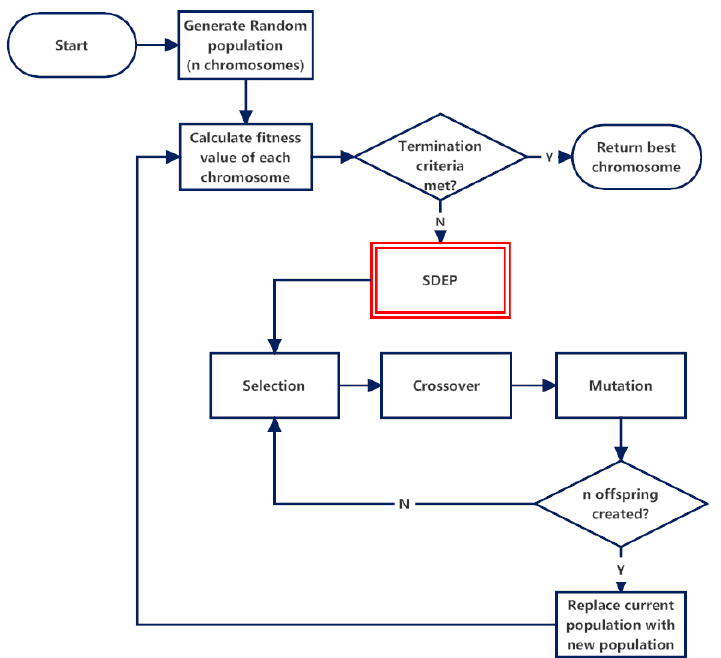
Figure 2. Flowchart of